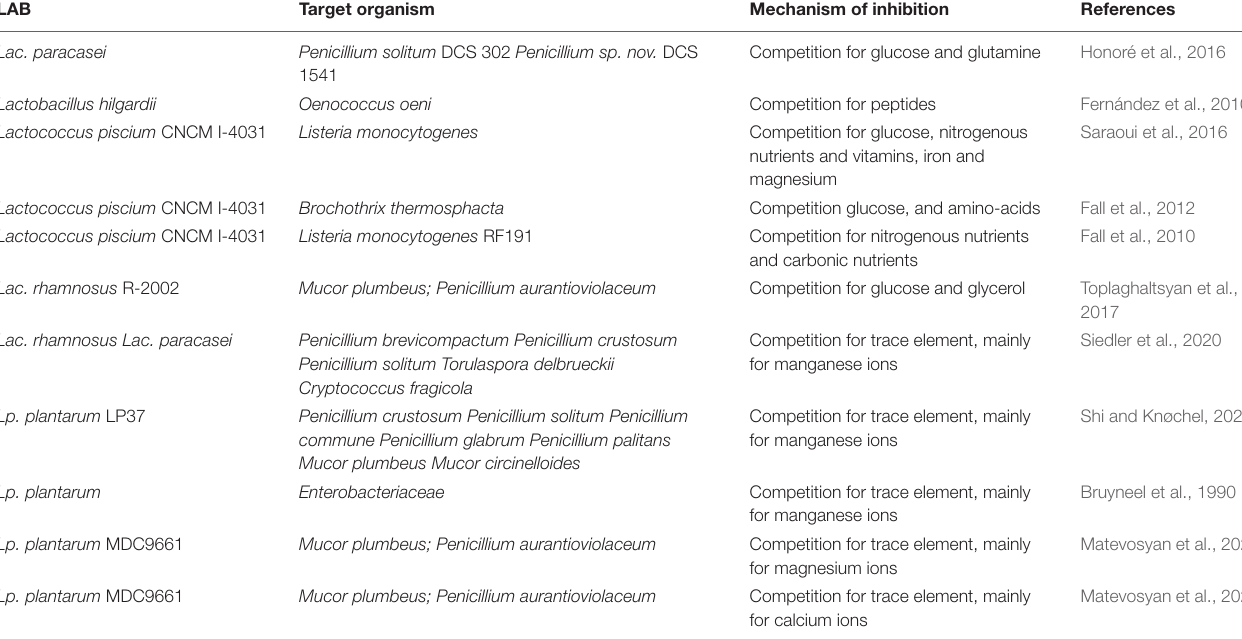
TABLE 4 | Examples of LAB providing biocontrol against spoilage organisms through competition for nutrients or